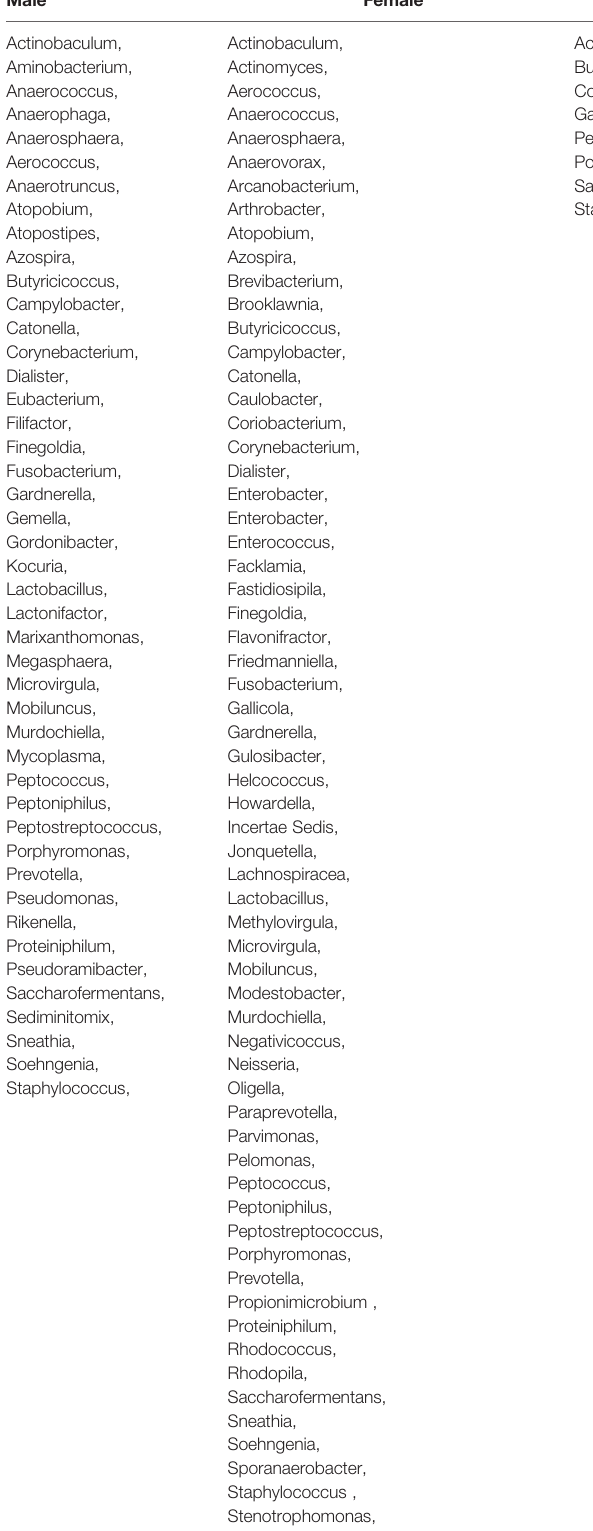
TABLE 1 | Comparison of known microbial diversity of human male and female urogenital systems during the onset of physiological disequilibrium. Male Female Common to Male & Female Location